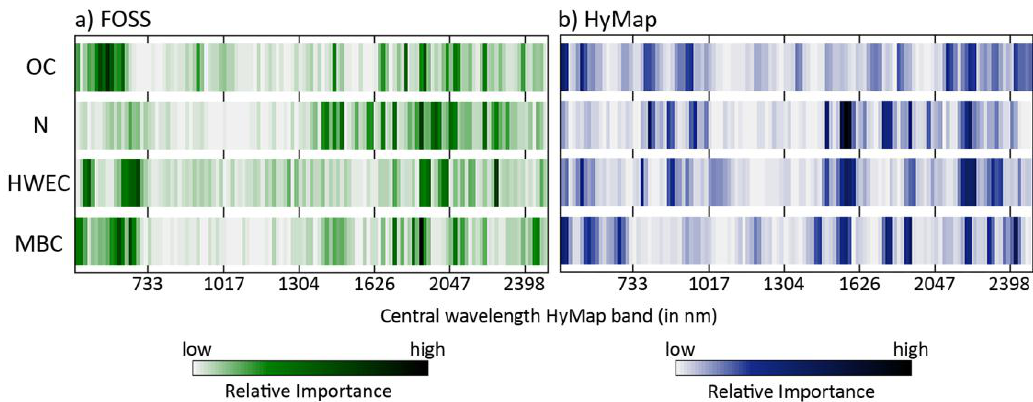
Figure 6. Relative importances of all 125 spectral variables for the estimation of the studied soil properties based on ( a ) laboratory and ( b ) airborne data. Table 5. Wavelengths with high RI values (RI > 0.02) identified on FOSS XDS and HyMap data for HWEC and MBC (Vis: 400–700 nm, NIR: >700–1300 nm, SWIR: >1300–2500 nm; central wavelengths (rounded to the nearest nm value) of the respective HyMap bands are given).